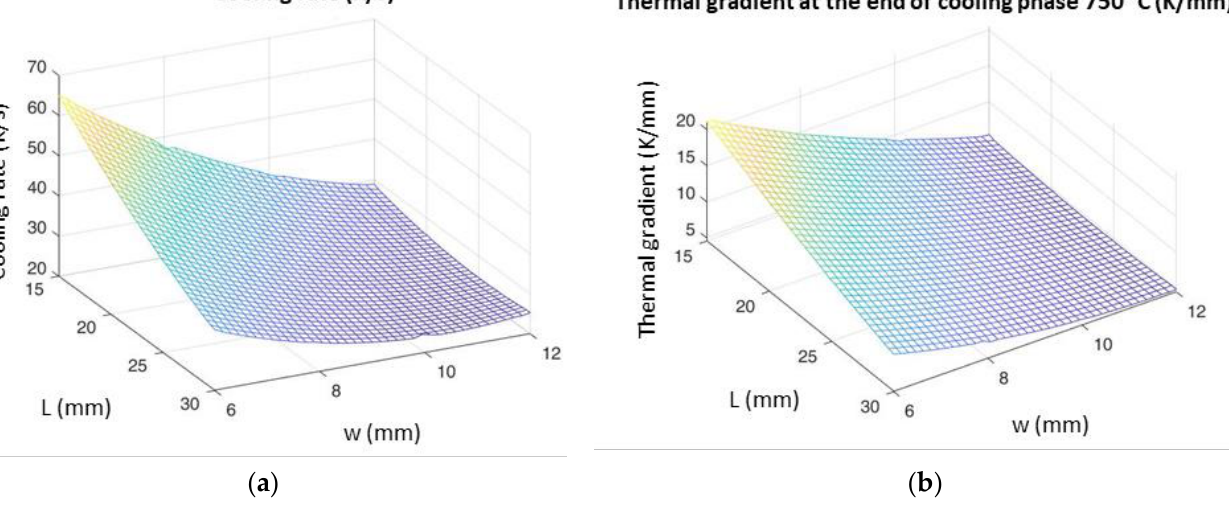
Figure 7. Metamodels for the USIBOR ® 2000 of ( a ) the cooling rate from the complete austenitization temperature (930 °C) to the test temperature (750 °C) and ( b ) the thermal gradient at the test temperature (750 °C) before the deformation phase as a function of L and w.